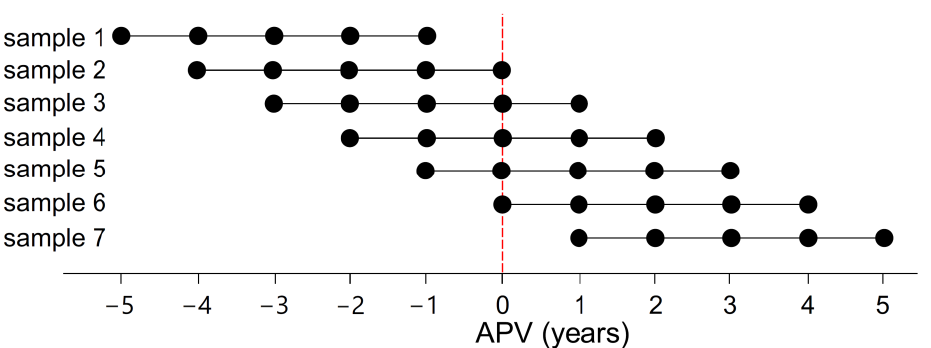
Figure 5. Sampling scheme of the testing samples 1–7. The individual five-point horizontal lines represent 7 permuted samples (all with five measurements one year apart) and the x -axis indicates the distance of each measurement from the population Age at Peak Velocity (APV) for the given sex. Thus, for example, the first measurement of sample 1 corresponds to an age 5 years before the APV and the fifth measurement of sample 1 corresponds to an age 1 year before the APV.